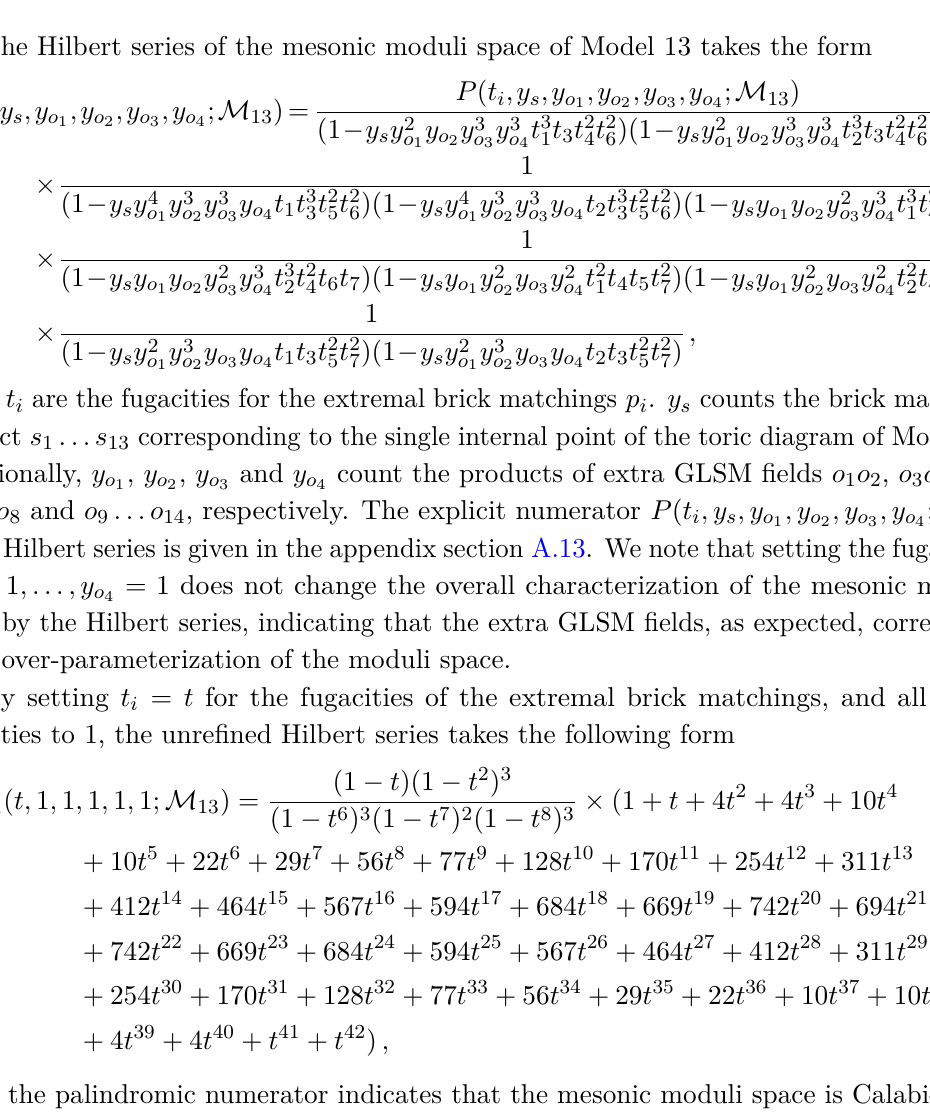
Figure 35 . Toric diagram for Model